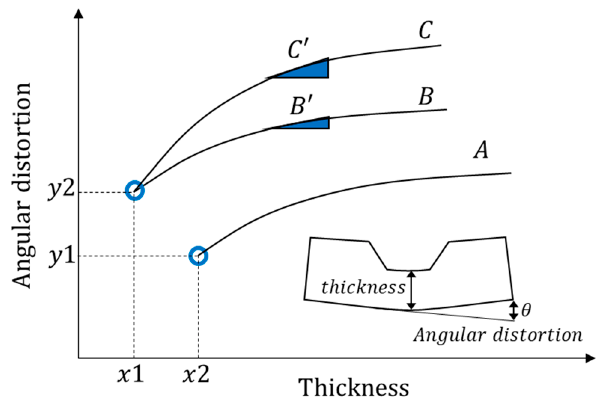
Figure 8. Prediction curve of angular distortion based on Equation (11).